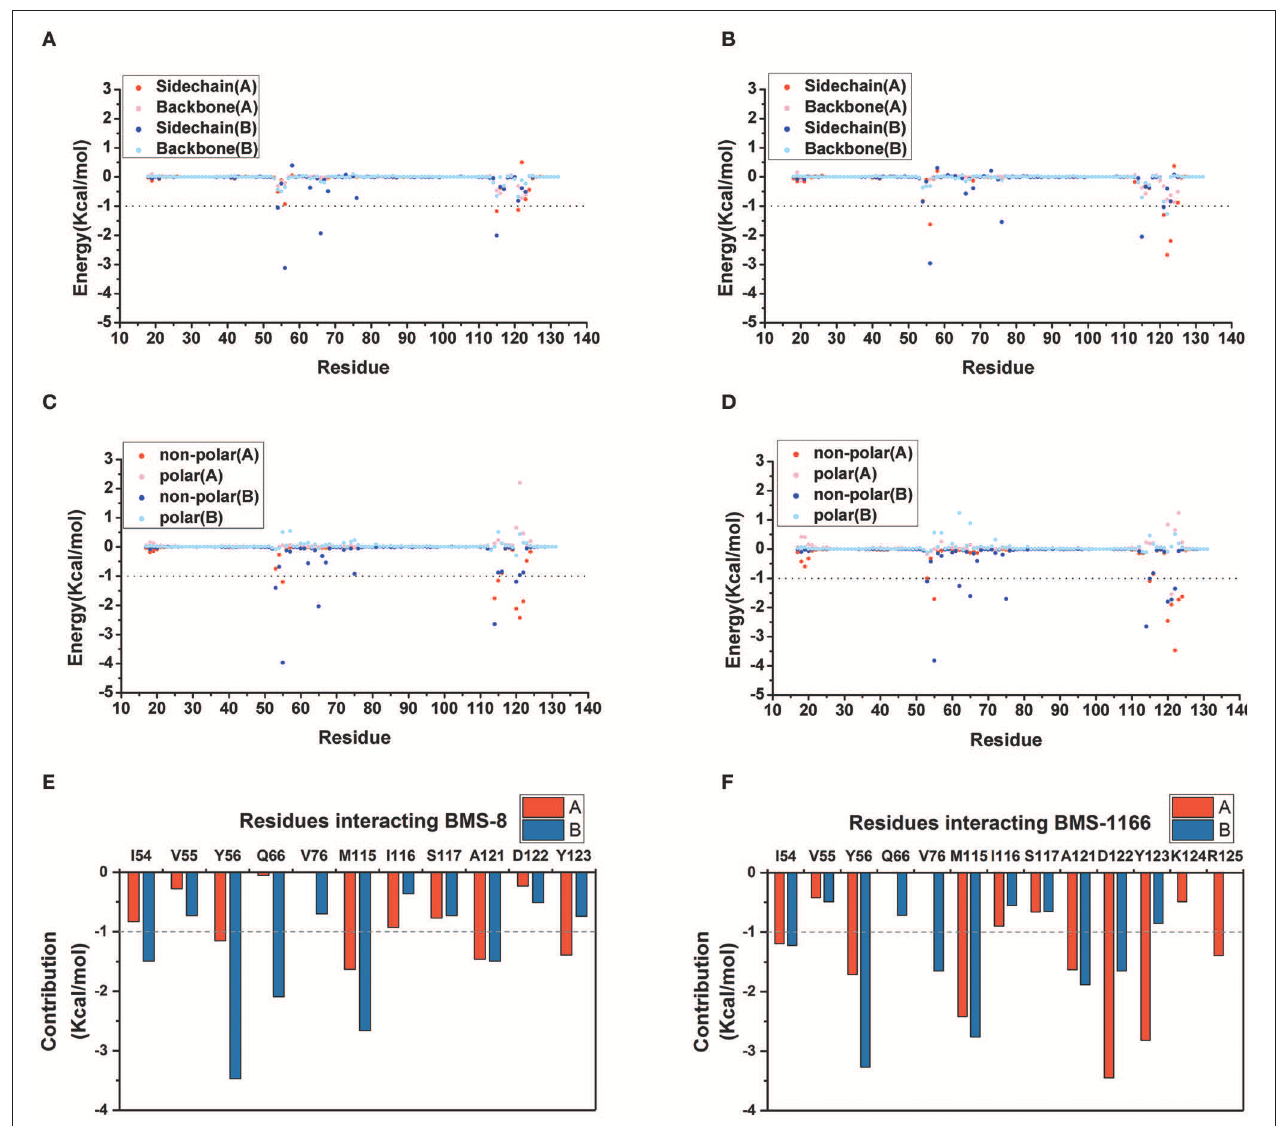
FIGURE 4 | The residue energy decomposition of the key residues for BMS-8 (A,C,E) and BMS-1166 (B,D,F) dimer systems. (A,B) The energy contribution of sidechain and backbone, (C,D) the energy contribution of polar and non-polar interaction, (E,F) the total energy contribution for each residue. The cutoff value of the energy contribution for key residues were set as − 1 kcal/mol.